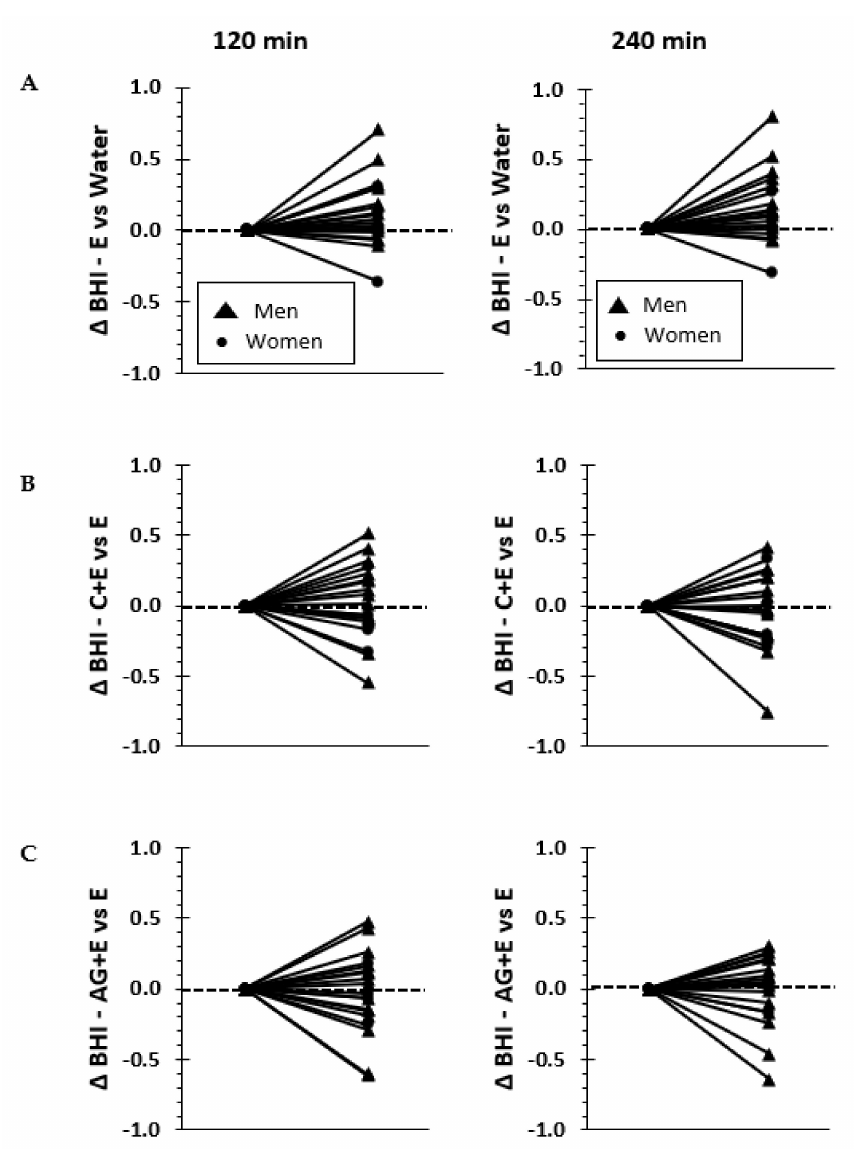
Figure 3. Individual subject data illustrating the net change in Beverage Hydration Index (BHI) relative to water (versus electrolytes) in Panel A ; relative to electrolyte base solution (versus carbohy- drate added) in Panel B and relative to electrolyte base solution (versus dipeptide added) in Panel C at 120 min (left columns) and 240 min (right